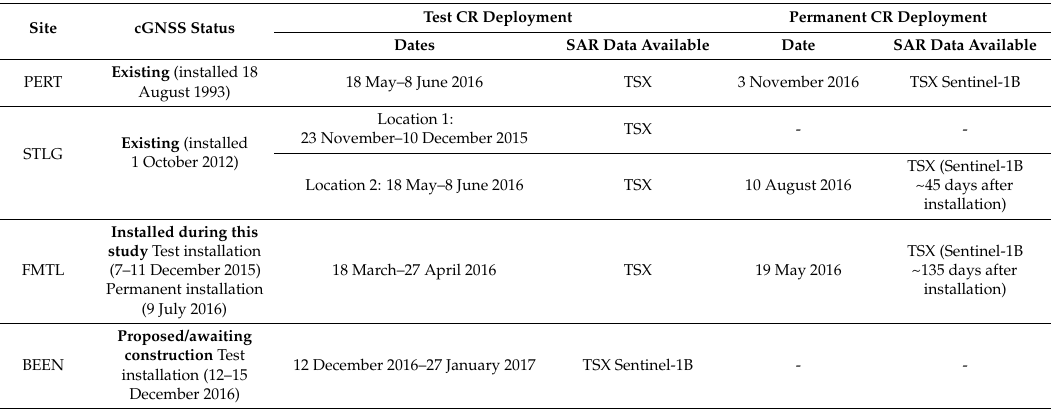
Table 2. Co-located cGNSS and CR installations in the Perth region described in this study. Included are the dates of test/permanent CR deployment and the availability of SAR